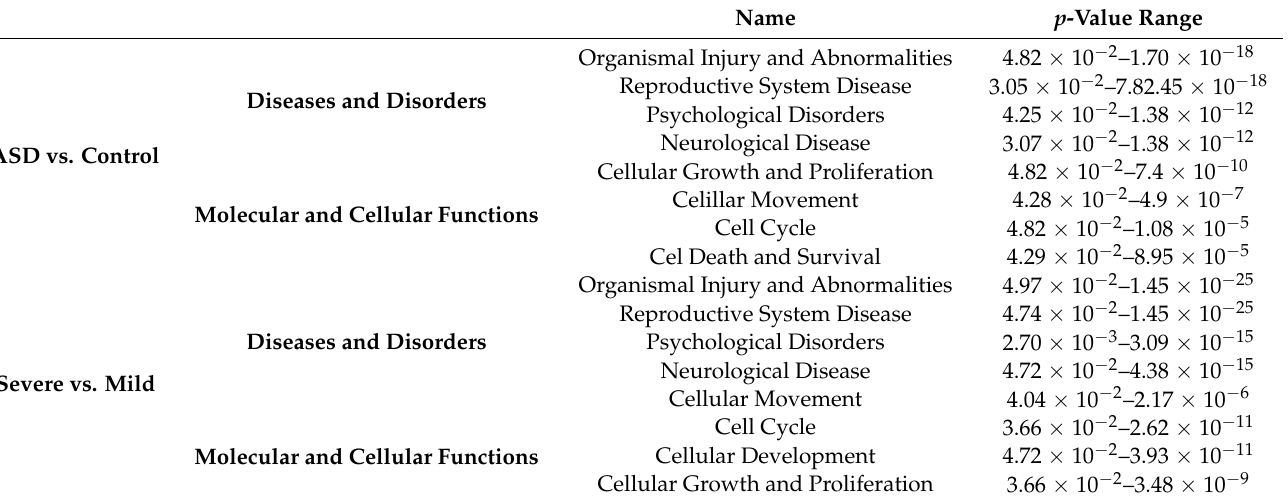
Table 10. Ingenuity Pathways Analysis (IPA)